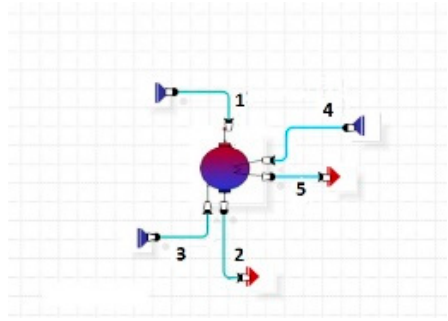
Figure 3. Detail of the condenser software representation taken from Figure 2.